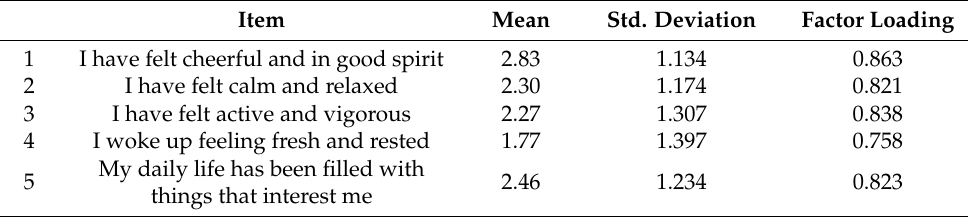
Table 2. Descriptive statistics of the items in WHO-5. Item